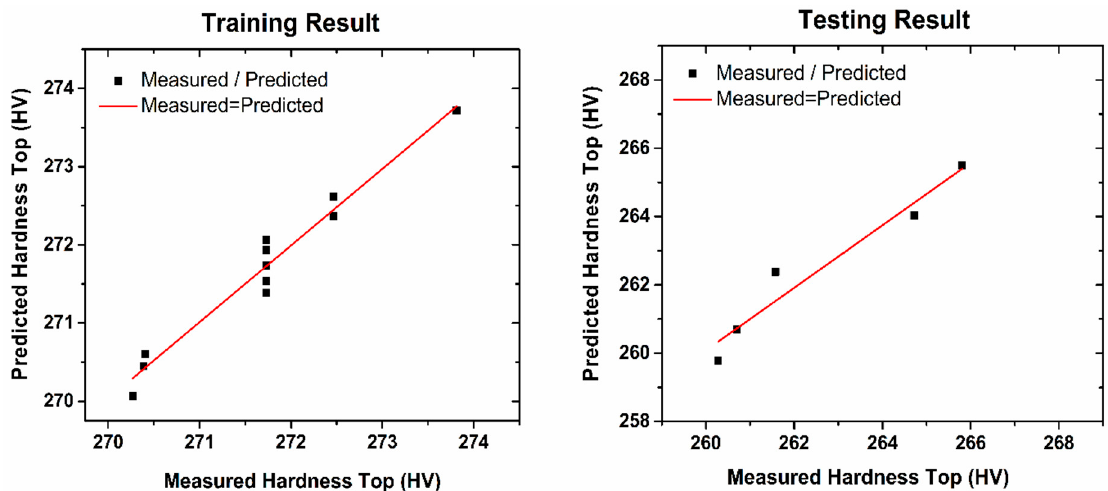
Figure 5. Comparison between the measured and the predicted hardness tops in the training/testing phases. Table 4. The statistical report of linear regression in the training and testing phases (hardness top). Statistical Parameters